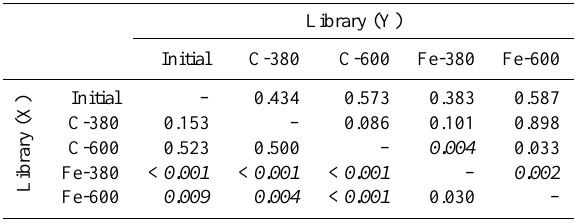
Table 3. Significance levels for differences among rbcL cDNA li- braries as calculated with LIBSHUFF. p values<0.05 are italicized.